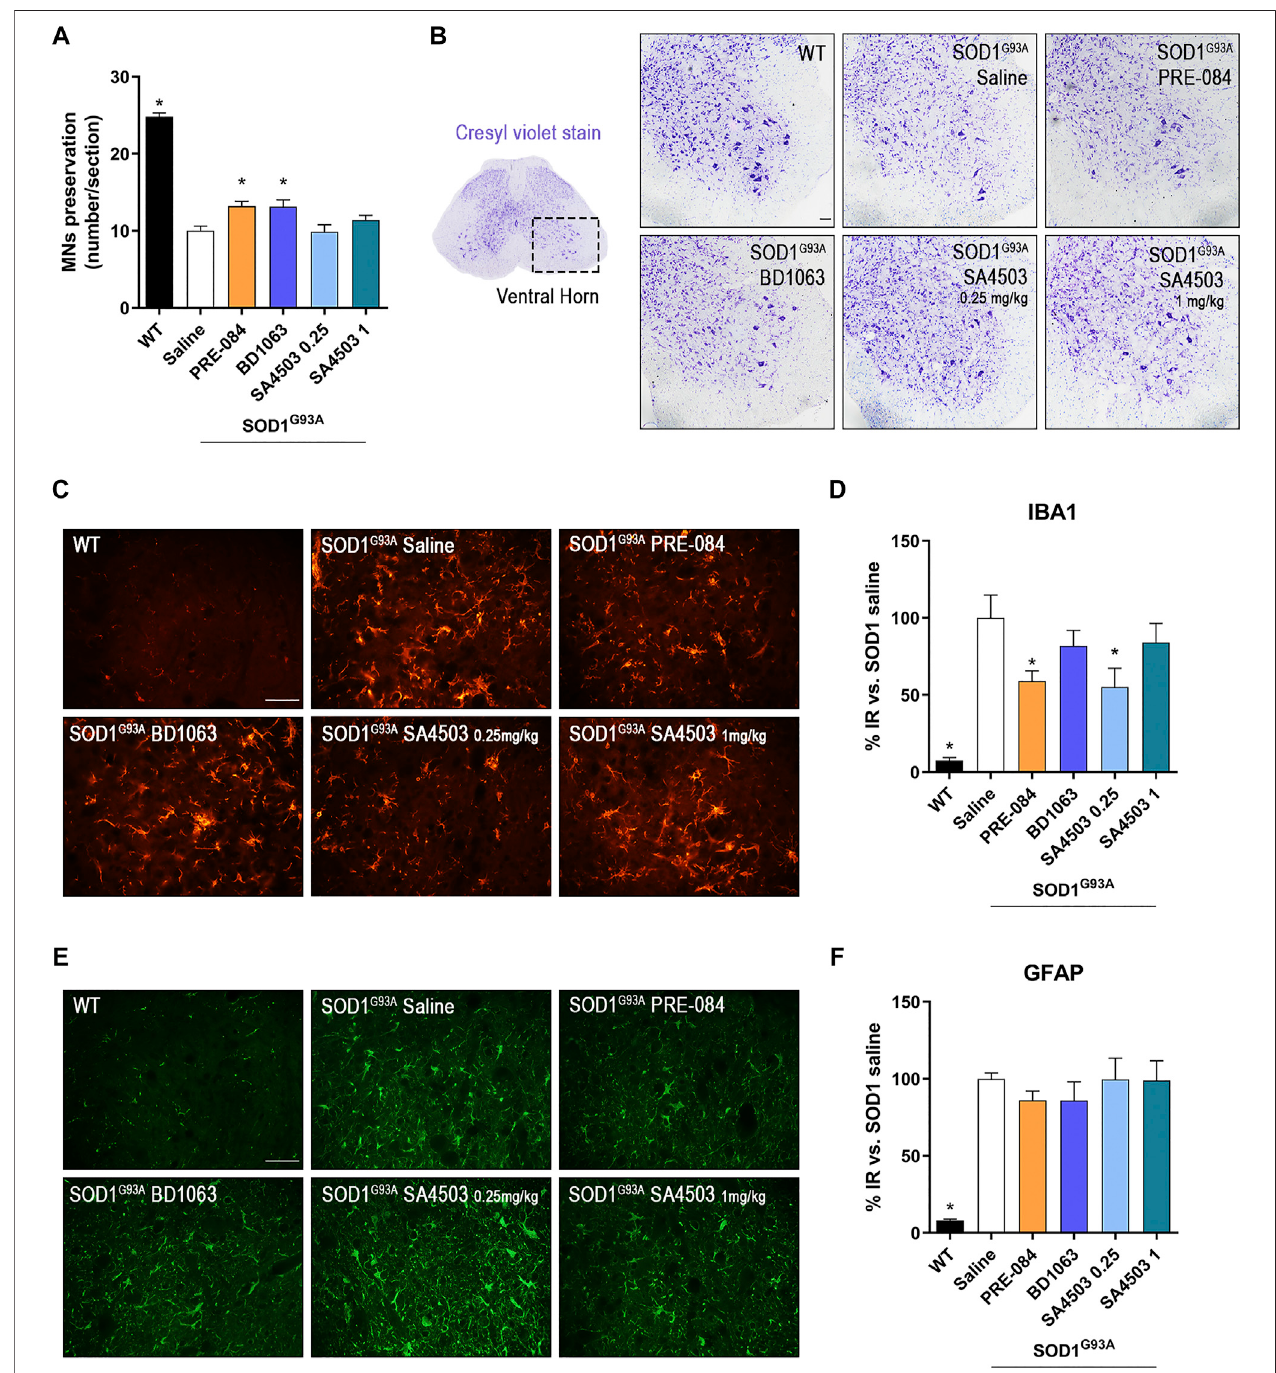
FIGURE 3 | PRE-084 and BD1063 reduce spinal MN degeneration and decrease microgliosis in SOD1 G93A female mice at 16 weeks of age (A) Quanti fi cation of surviving MNs (mean number of MNs per section ± SEM) in the lumbar spinal cord, showing improved MN preservation with Sig-1R ligands PRE-084 and BD1063. (B) Representative spinal cord images of MNs stained with cresyl violet. Scale bar 100 μ m. (C, E) Representative images of immunoreactivity for Iba1 (C) , a marker for microglia, and GFAP (E) , a marker of astrocytes, in the ventral horn of WT and SOD1 G93A mice with or without Sig-1R treatments. Scale bar 50 μ m. D, F) Graphs showingthequanti fi cationofpercentage ofIba-1 (D) andGFAP (F) immunolabelinginventralhornofspinalcord(n (cid:1) 10WT,n (cid:1) 10SOD1saline,n (cid:1) 8SOD1BD1063,n (cid:1) 7 SOD1 SA4503 0.25 mg/kg, n (cid:1) 7 SOD1 SA4503 1 mg/kg and n (cid:1) 10 SOD1 PRE-084 mice). * p < 0.05 vs SOD1 G93A saline mice.